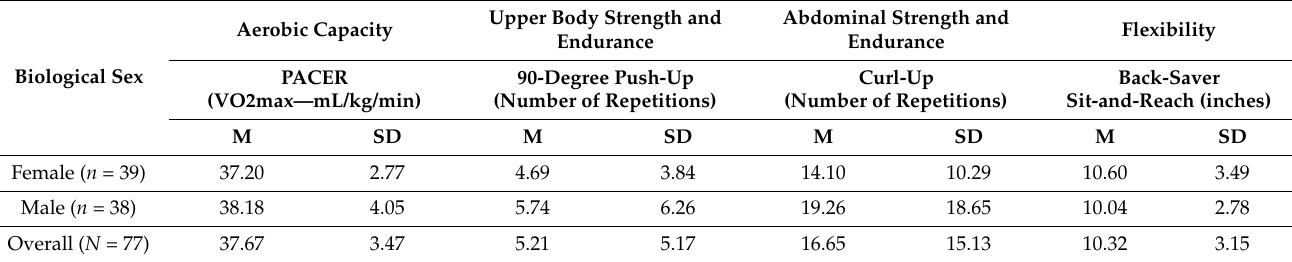
Table 2. Results for Student Performance.